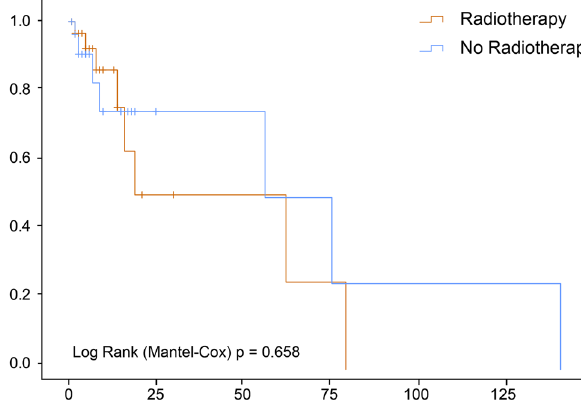
Figure 3: Radiotherapy does not impact survival of patients with hepatoid adenocarcinoma of the